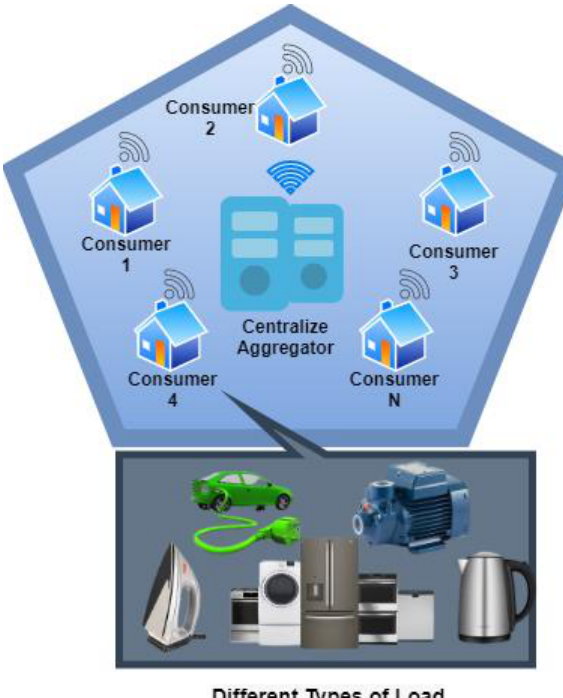
Figure 7. Residential